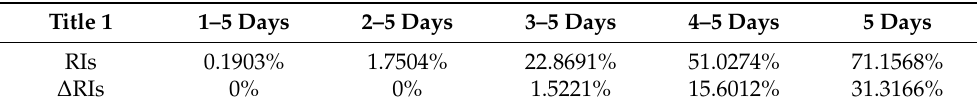
Table 1. Percentages of RIs and ∆ RIs, which were significantly changed for different time intervals after the water shortage